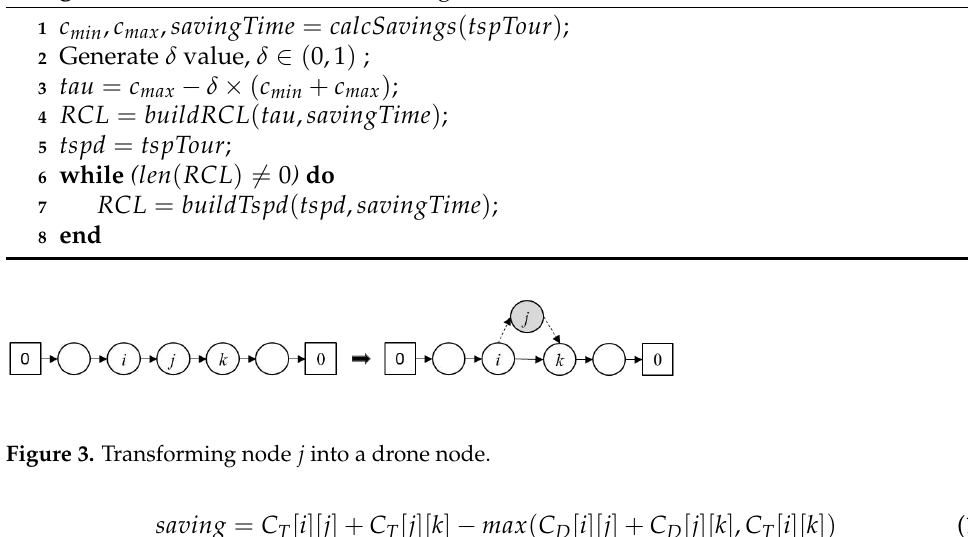
Algorithm 2: randmizedInitTSPD Algorithm